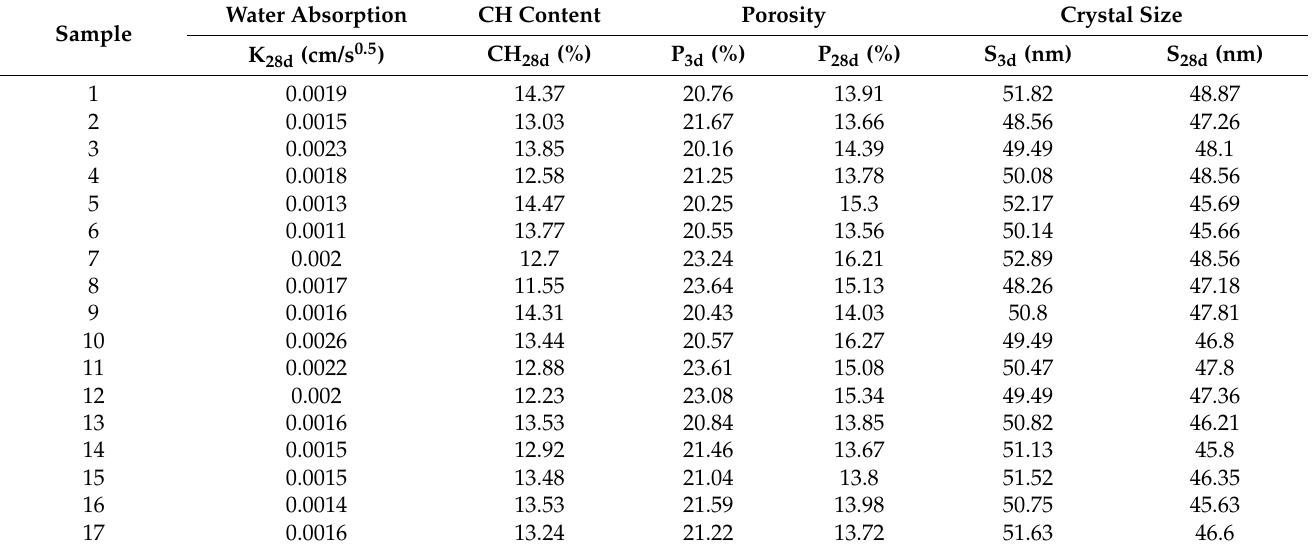
Table 5. Partial test results of experiment 2.